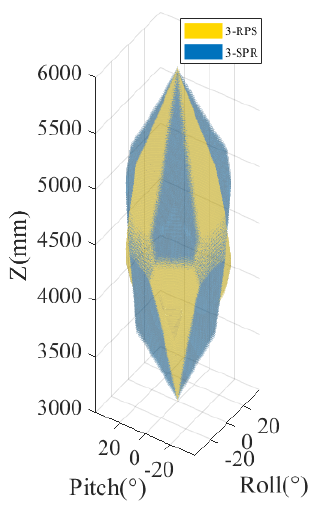
Figure 9. Attitude workspace comparison diagram of two platforms.